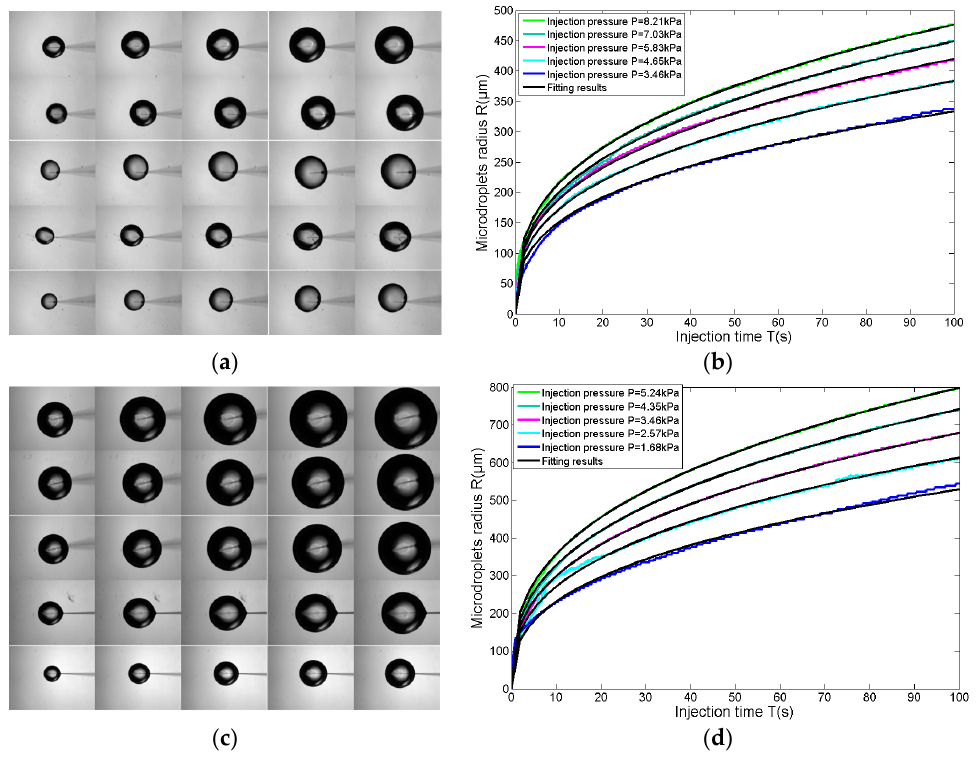
Figure 8. Microdroplet generation based on the substrate-contacting method. ( a ) The images of microdroplets at 20 s, 40 s, 60 s, 80 s, and 100 s, and the five rows of images corresponding to the five groups of experiments, respectively. The radius at the micropipette opening is 3.5 μ m; ( b ) microdroplet radii of five groups of experiments within 100 s. They are fitted with the equations in Table 3 (the black curve), with r 2 > 0.99; ( c ) the images of microdroplets at 20 s, 40 s, 60 s, 80 s, and 100 s, and the five rows of images corresponding to the five groups of experiments, respectively. The radius at the micropipette opening is 6.9 μ m; ( d ) microdroplet radii of five groups of experiments within 100 s. They are fitted with the equations in Table 4 (the black curve), with r 2 > 0.99.